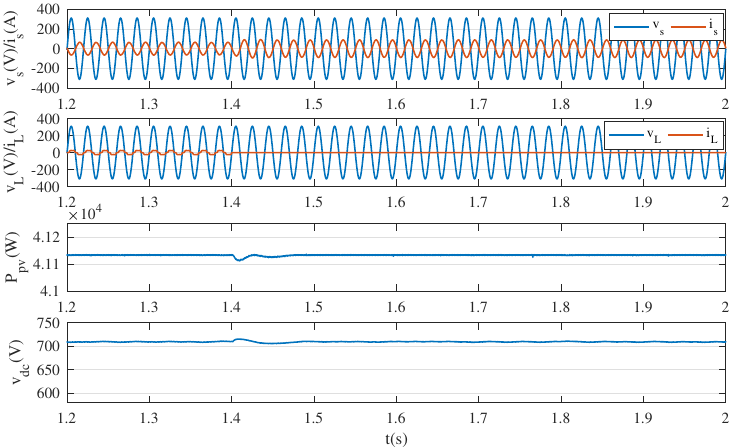
Figure 11. Simulation results under loads sudden decrease.